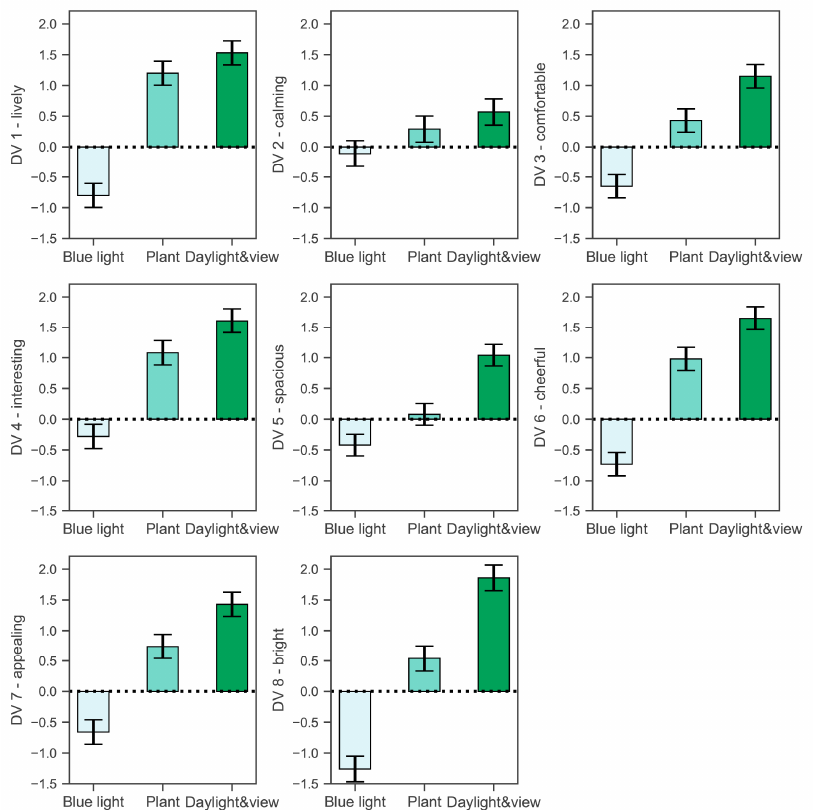
Figure 2. Estimated effects (with 95% CI) of the three design iterations compared to the baseline. Of the two biophilic designs, the one with daylight and view has a greater impact on participants’ perception of the space than the one with indoor plants. Figure 2 visualizes the estimated fixed effects ( β and 95% confidence interval) of the three designs, relative to the baseline on different semantic ratings. Specifically, the design with daylight and view was found to have a statistically significant association with the brightness rating (1.86, 95% CI: 1.65, 2.06), followed by a positive effect on the cheerfulness rating (1.65, 95% CI: 1.46, 1.84), and an increase in the rating of interesting (1.61, 95% CI: 1.41, 1.81), lively (1.53, 95% CI: 1.33, 1.73), and appealing (1.43, 95% CI: 1.23, 1.63). It was also related to a smaller increase in comfort rating (1.15, 95% CI: 0.96, 1.34) and spaciousness rating (1.04, 95% CI: 0.86, 1.22), as well as the smallest increase in how calming the space was perceived as being (0.57, 95% CI: 0.36, 0.78).